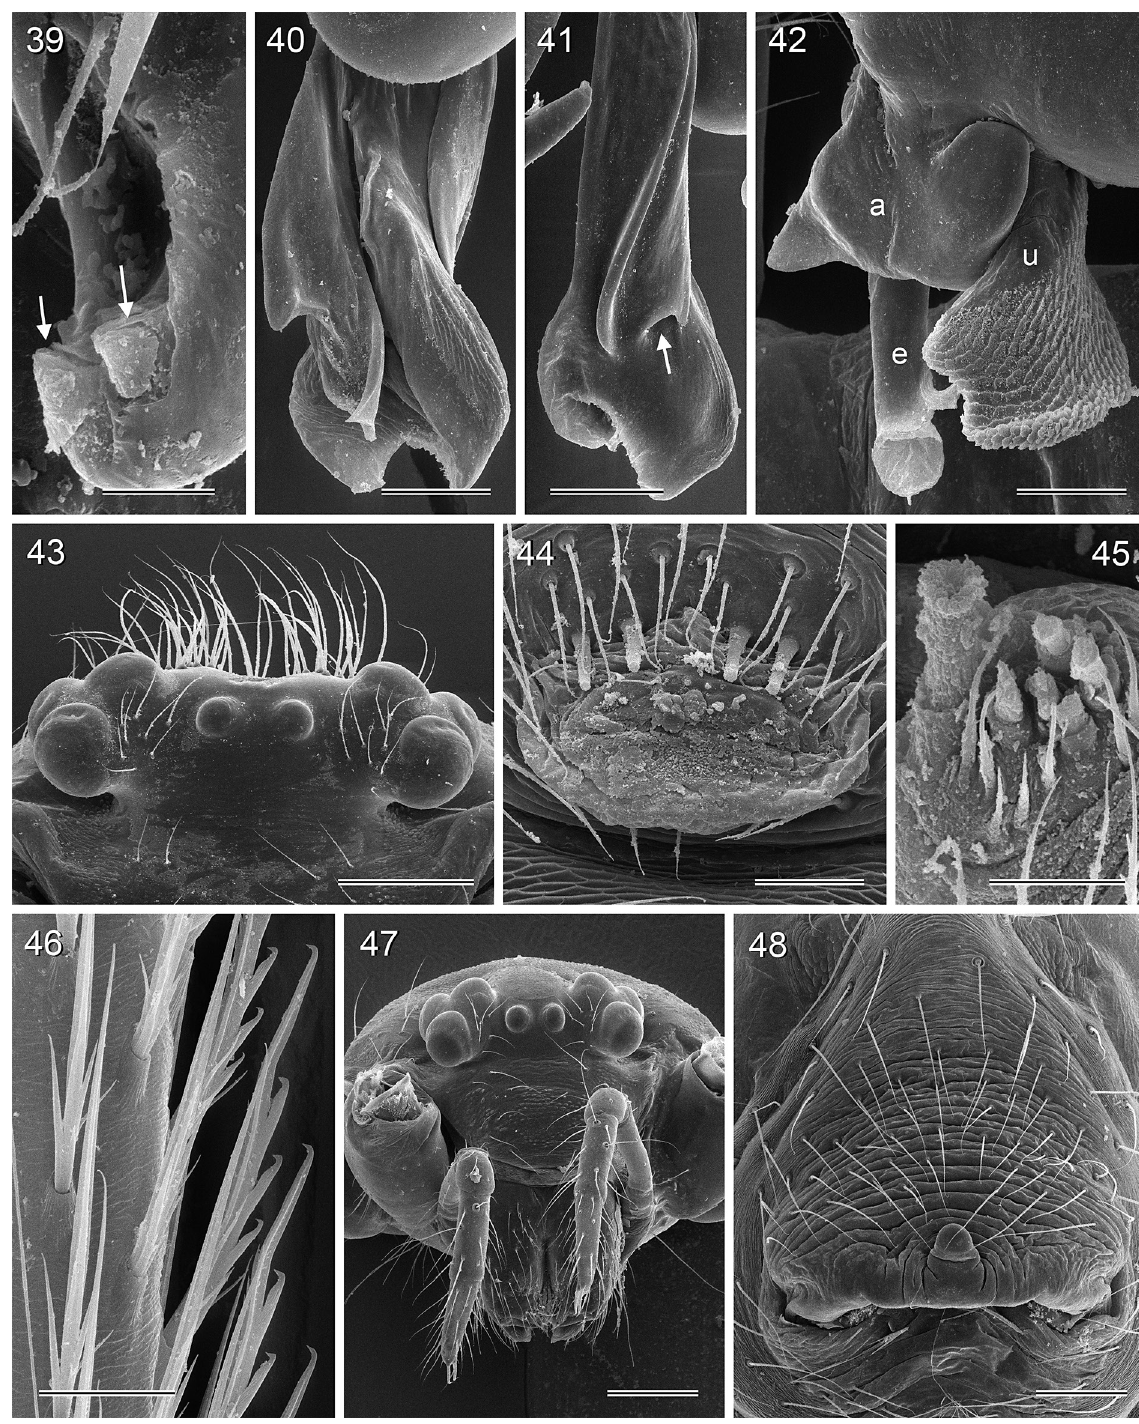
Figs 39–48. Pholcus erawan Huber, 2011, ZFMK Ar 15016–17. 39 . Male distal cheliceral apophysis (arrows point at modified hairs). 40 . Left procursus, prolateral view. 41 . Right procursus, retrolatero-dorsal view (arrow points at distal pocket). 42 . Left bulbal processes, distal view. 43 . Male ocular area, frontal view. 44 . Male gonopore. 45 . Female ALS. 46 . Comb-hairs on male tarsus 4. 47 . Female prosoma, frontal view. 48 . Epigynum, ventral view. Abbreviations: a = appendix; e = embolus; u = uncus. Scale lines: 10 µm (39); 20 µm (45–46); 40 µm (44); 60 µm (42); 80 µm (40); 100 µm (41, 48); 200 µm (43,